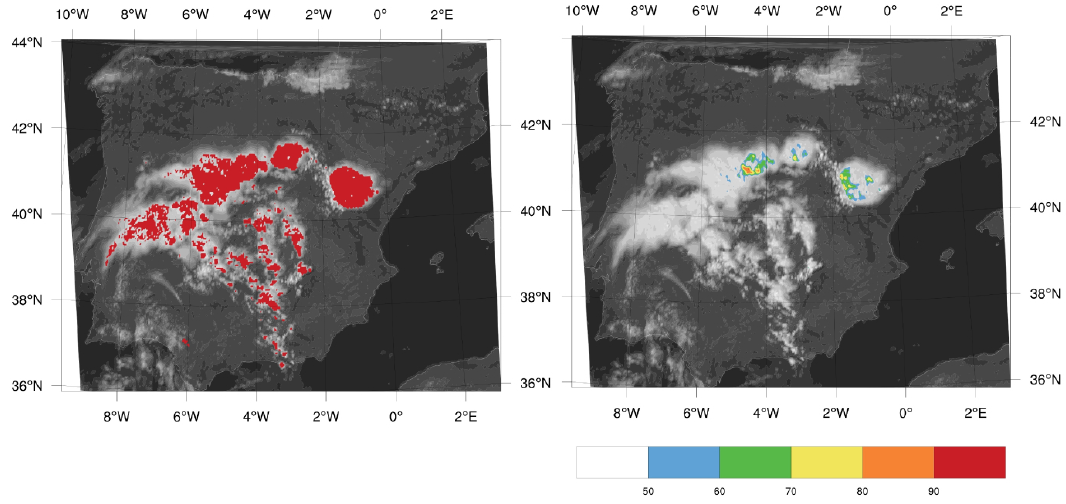
Fig. 6. 14:00UTC on 12 August 2011. Left: convective areas delineated by CM. Right: HDT outputs in terms of hail